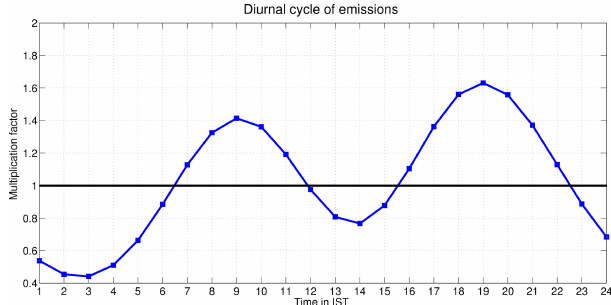
Figure 1. The prescribed diurnal variation to the emissions of BC, OC, sulfate, SO 2 , CO, NO and NO 2 in this